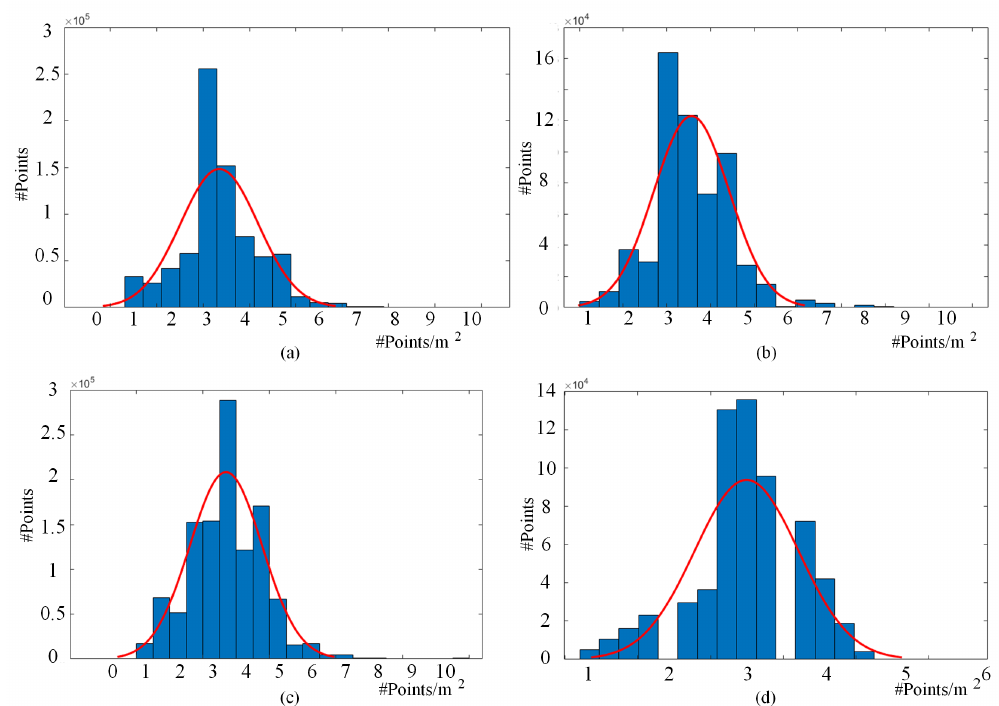
Figure 4. Distributions of point density. Red lines are the fitted tendency. ( a ) Section 1, ( b ) Section 2, ( c ) Section 3, and ( d ) Section